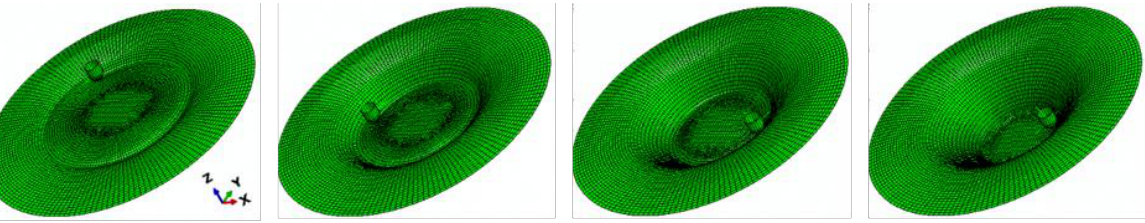
Figure 11. Blank deformation and deformed mesh over various stages (initial stage on left and final stage on right) of PA-SPIF.